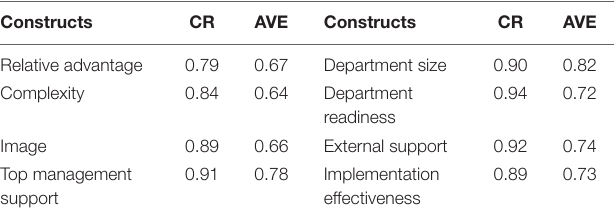
TABLE 8 | Composite reliability and AVE (dependent variable: implementation effectiveness).